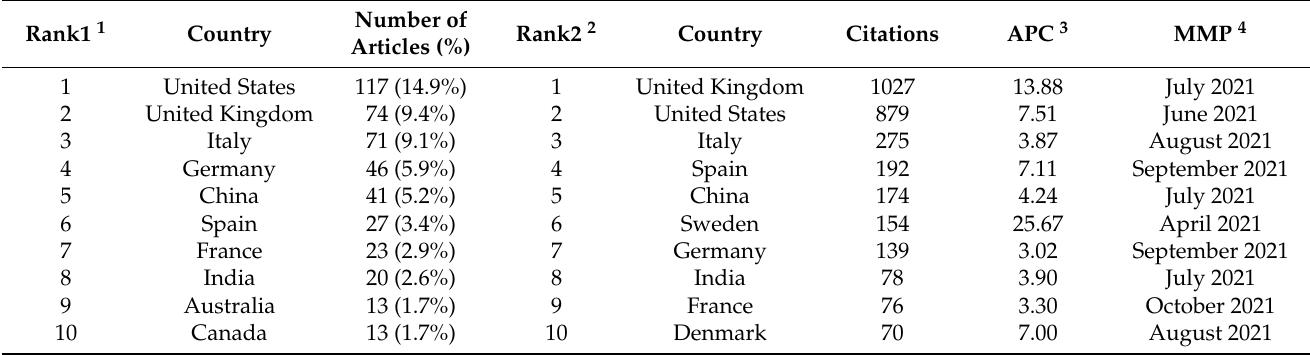
Figure 2. Monthly number of the publications. Table 1. The top 10 most active countries based on the corresponding authors’